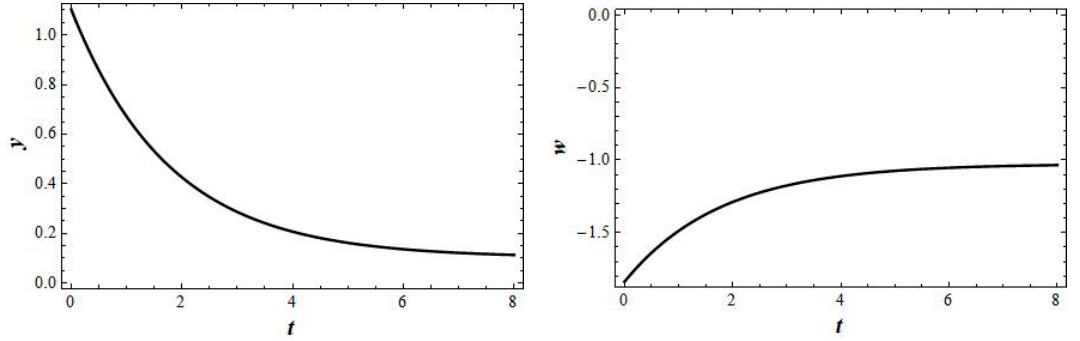
Figure A4. Exact solutions of system (2) when b 1 = 2.266, b 2 = 1, b 3 = 2.092, b 4 = 2, k = 1, c 1 = 1, according to Formula (16).